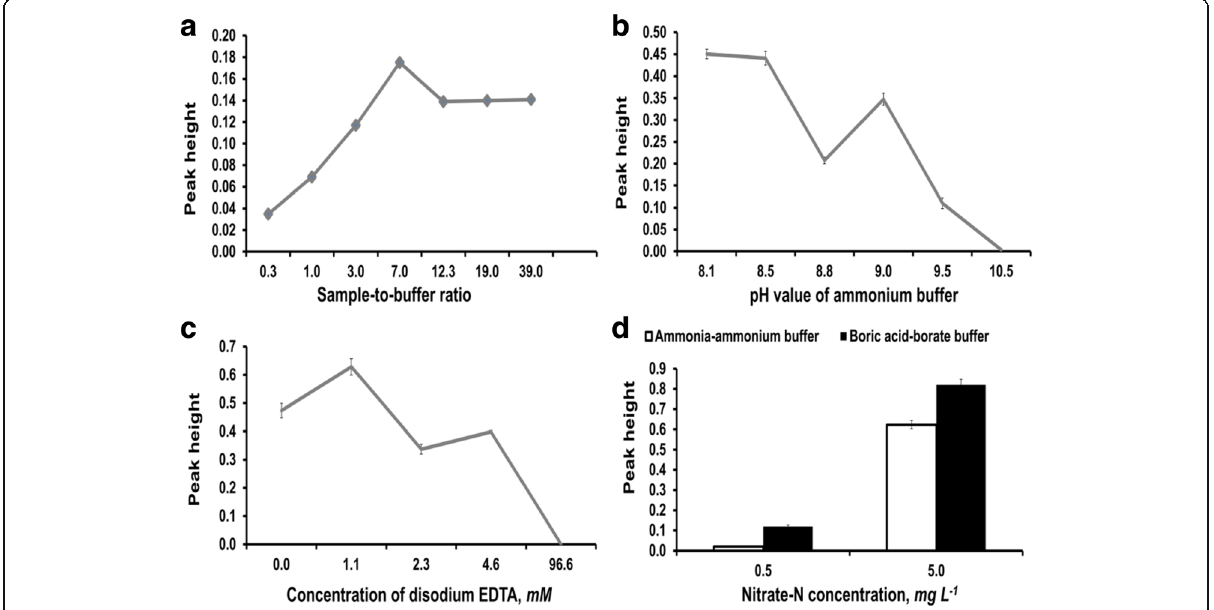
Fig. 3 a Effect of sample-to-buffer ratio on Zn reduction illustrating increase in sensitivity with increasing sample-to-buffer ratio. b Effect of buffer pH on Zn reduction illustrating decrease in sensitivity with increasing buffer pH. c Effect of Na 2 EDTA concentration on Zn reduction using 10.0 mg N L − 1 standard. d Comparison of ammonium buffer to borate buffer for the gas interference